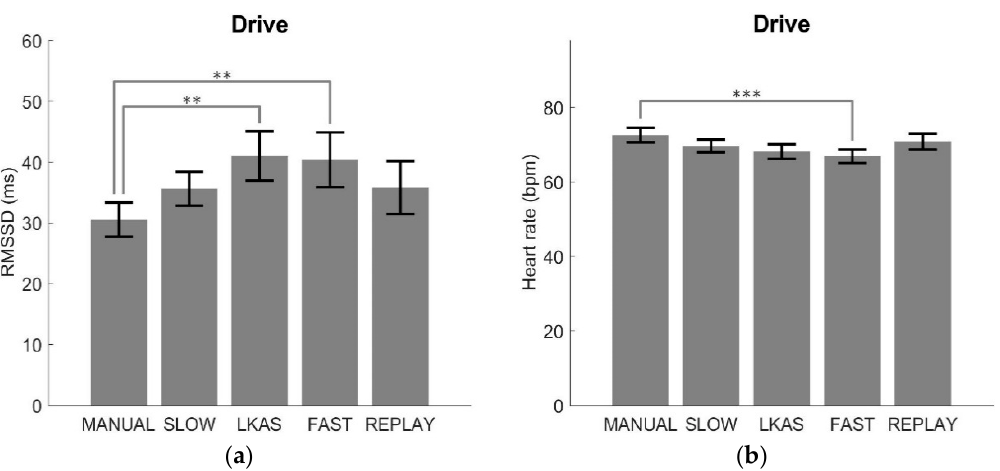
Figure 3 . ( a ) Root mean square of successive differences (RMSSD) and ( b ) heart rate (HR) plots